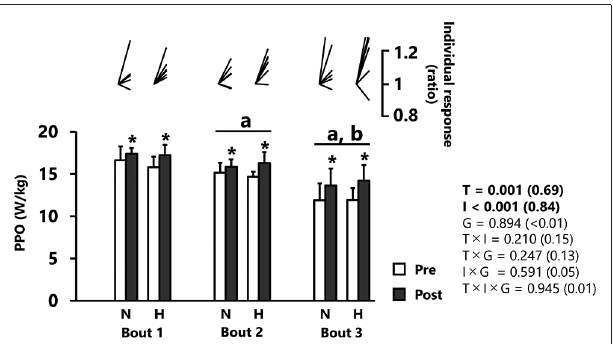
FIGURE 3 | Blood lactate concentration (BLa). All values are expressed as mean with SD for error bars. Individual response is shown as a ratio of the value between pre and post within participants. Significance level and effect size are expressed as P -value (Cohen’s d ) for main effects and interactions. (*) 0.05 < p < 0.10 Tendency between pre- and post-test. a p < 0.001 Compared with before. b p < 0.001 Compared with bout 1. N, normoxic group; H, hypoxic group; T, time; I, interval; G, group.